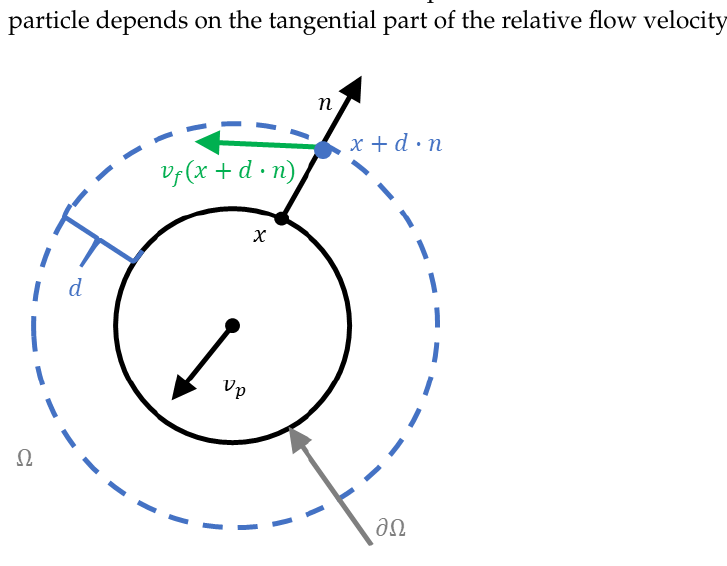
Figure 4. Variables used for shear force calculation in CFD-DEM coupling.